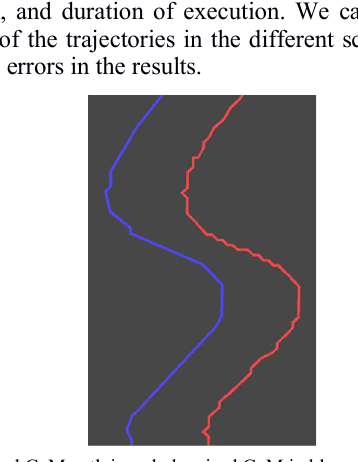
Fig. 14 Original CoM path in red, denoised CoM in